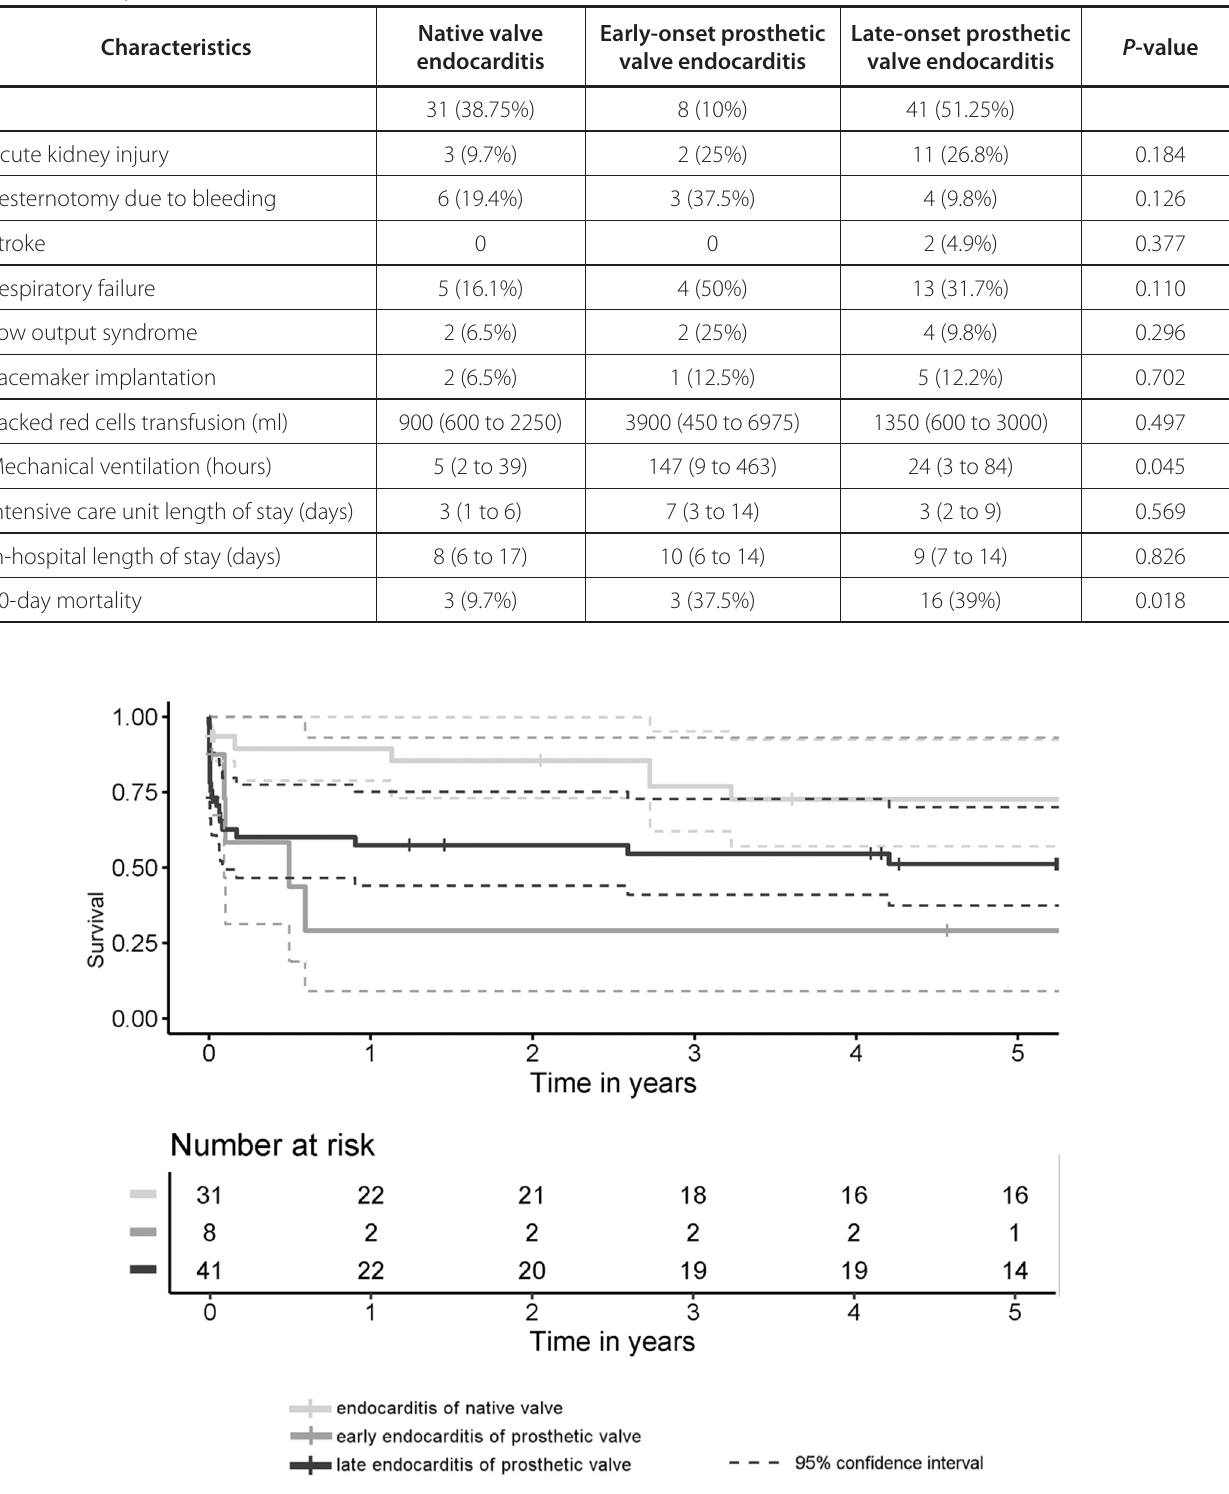
Fig. 1 - Cumulative survival of all three analyzed groups. The survival profiles were compared with log-rank test, generally (P=0.044) and pairwise: native valve endocarditis (NVE) vs. early-onset prosthetic valve endocarditis (PVE) (P=0.008), NVE vs. late-onset PVE (P=0.039), and early- vs. late- onset PVE